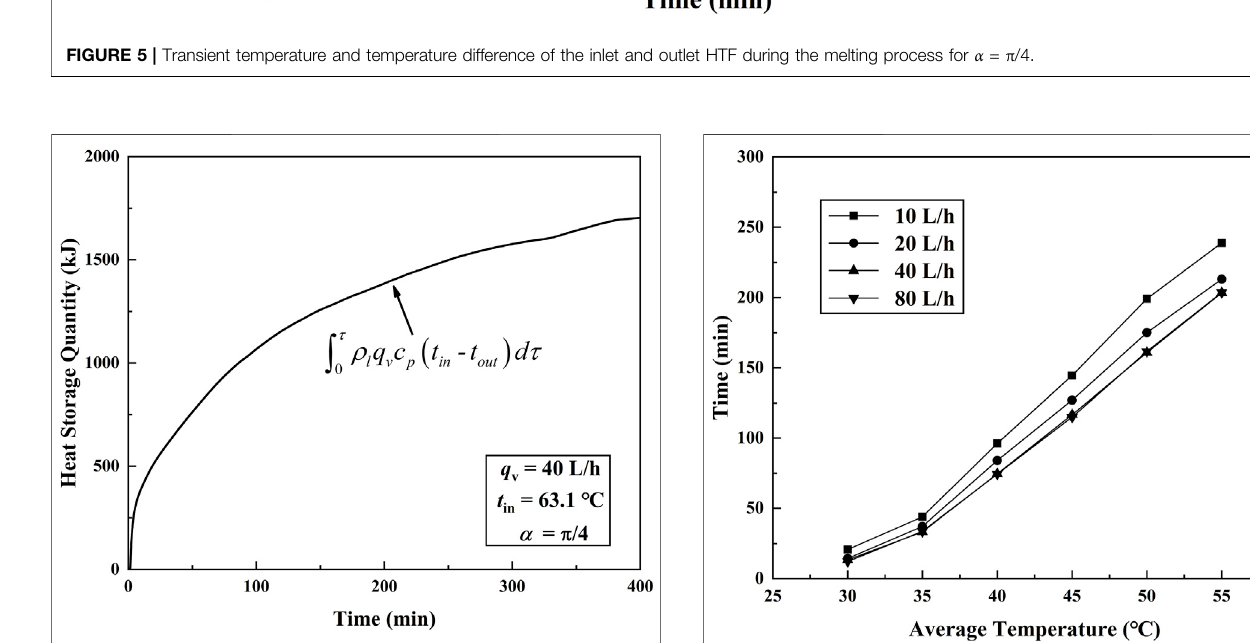
FIGURE 7 | Time required for PCM average temperature reached at different values for t in = 63.1 ° C, α = π